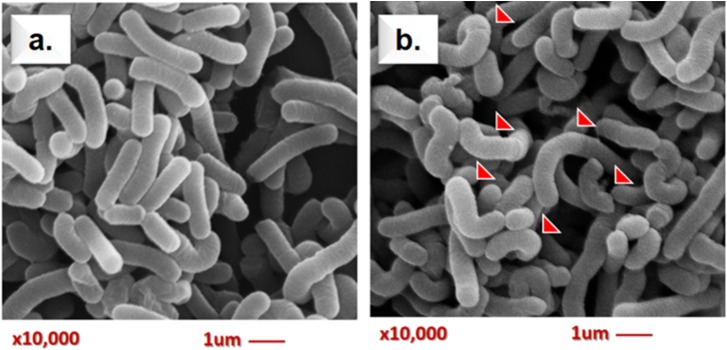
Scanning electron microscopy analysis of live Lcs cells + AFB1. (a) Control group (untreated Lcs). (b) Treatment group (Lcs incubated with 2 ug/ ml AFB1 for 1 h; 10,000 × magnification). Red arrows indicate structural changes induced by AFB1. The bacteria appeared irregular and rough on the surface as well as curve shaped.